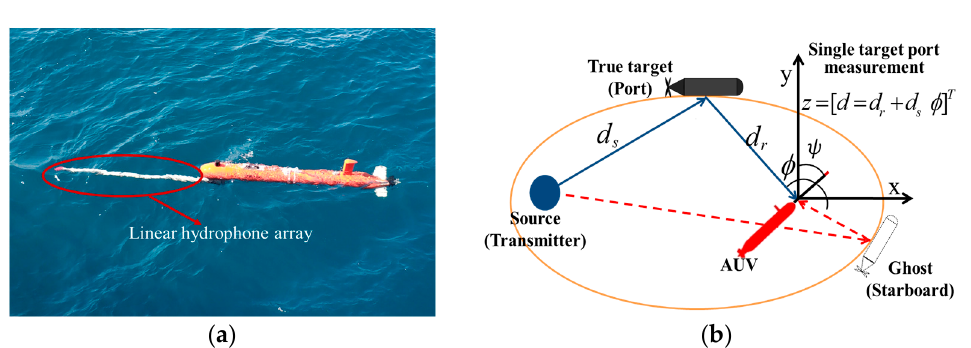
Figure 2. ( a ) The developed “TS-100” AUV is equipped with linear hydrophone arrays. ( b ) Schematic diagram of AUV measurement in bistatic